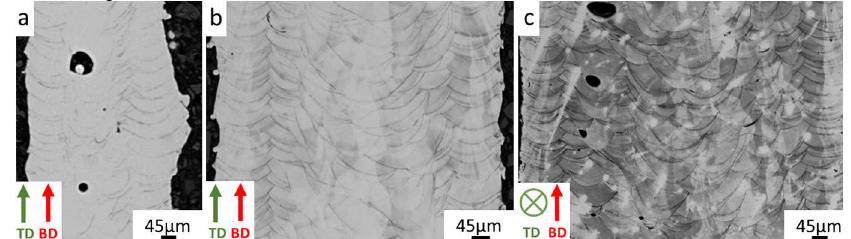
Fig. 2. Optical micrographs of Bd90_t05 (a), Bd90_t1 (b) and Bd0_t1 samples along the Tensile Direction (TD) with respect to the Building Direction (BD).